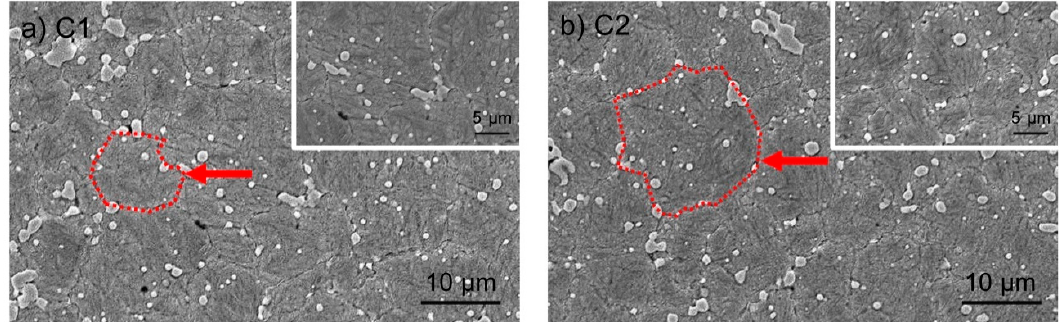
Figure 6. Microstructures of grade C steel after conventional heat treatment: ( a ) C1: 2 min of austenitization at temperature T A = 1230 °C and 3 × 2 h tempering at temperature T T = 550 °C; and heat treatment with deep cryogenic treatment: ( b ) C2: 2 min of austenitization at temperature T A = 1230 °C, 24 h of DCT at temperature T DCT = − 196 °C and 2 h tempering at temperature T T = 550 °C.